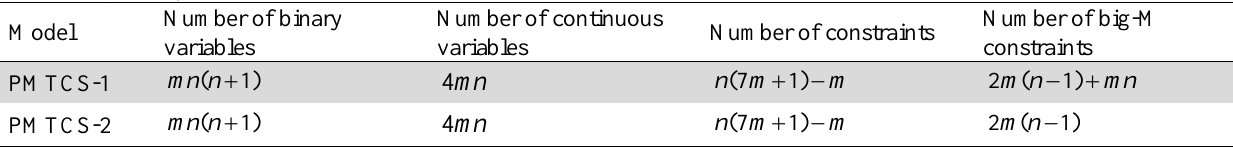
Size complexity of MILP